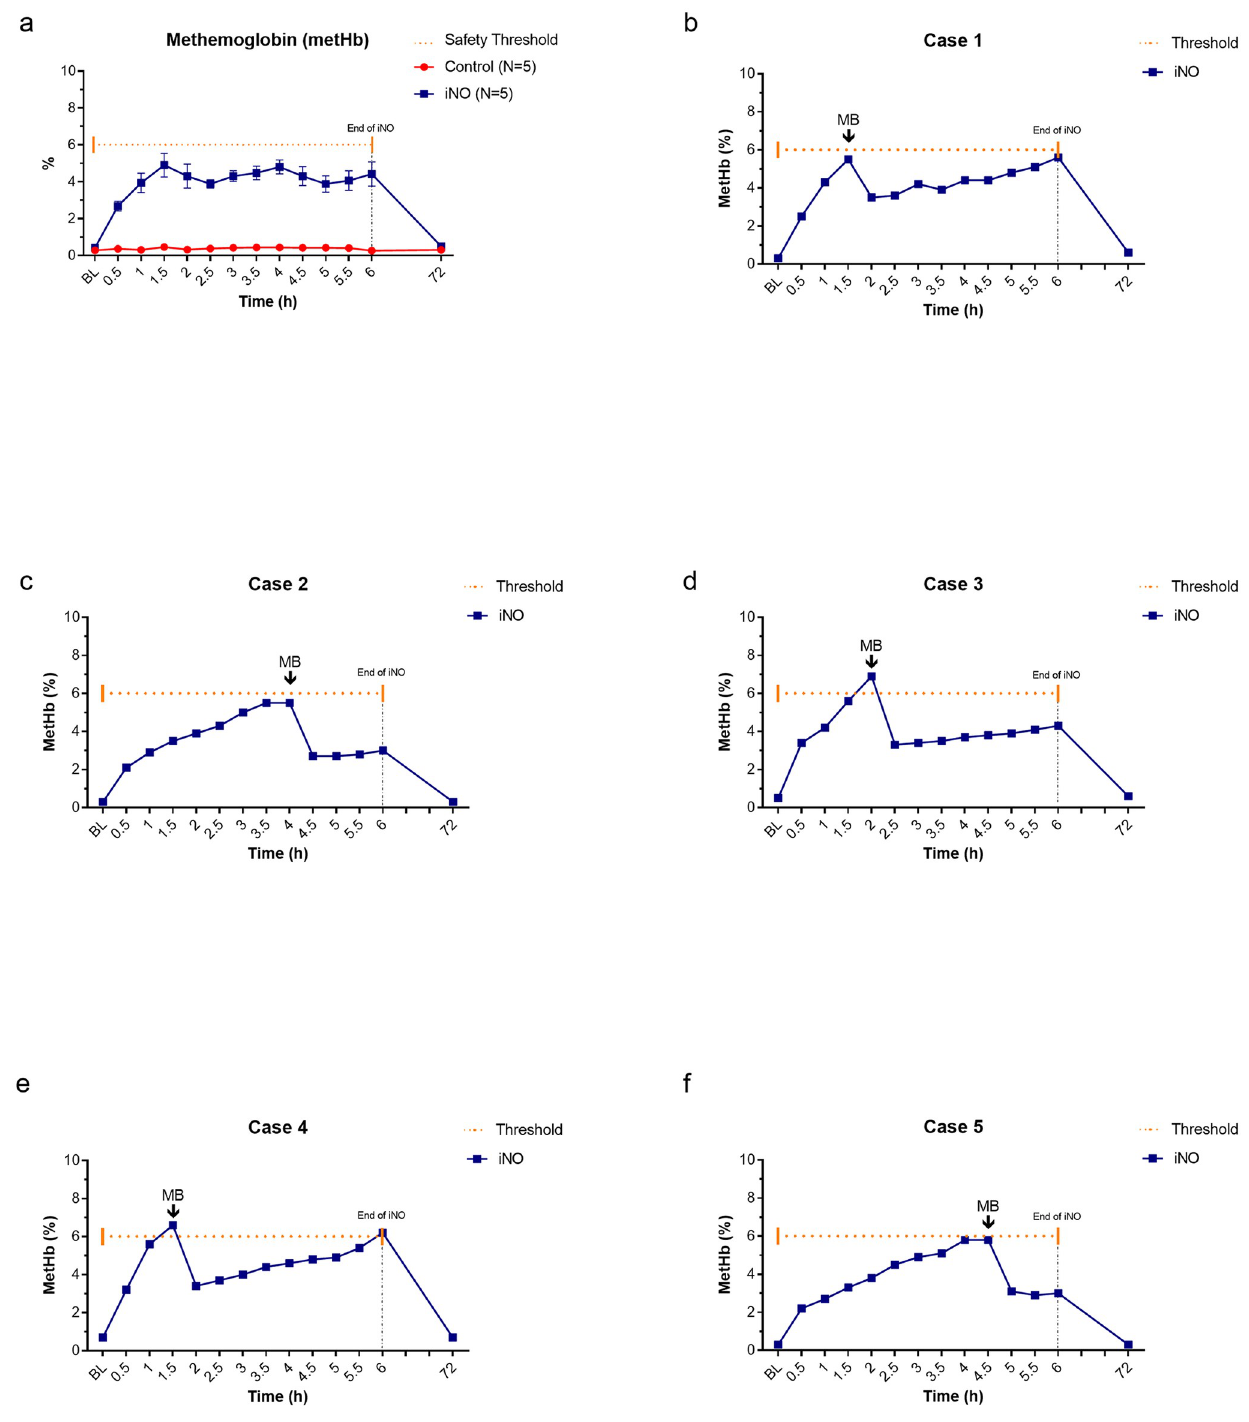
Fig 4. Methemoglobin (metHb) levels over time. MetHb was measured from an arterial blood sample every 30min during the intervention phase. Inhaled nitric oxide (iNO)-treated animals had significantly higher levels of metHb than controls (a). Variation over time of the metHb percentage and time of methylene blue administration is shown for each treated animal (b-f). The safety threshold for metHb was set at 6%. One dose of methylene blue (MB) during the entire intervention was sufficient to keep metHb levels below the safety threshold (6%). Definition of abbreviation: BL = baseline, MB = methylene blue, metHb = methemoglobin, iNO = inhaled nitric oxide, and ns = non-significant.